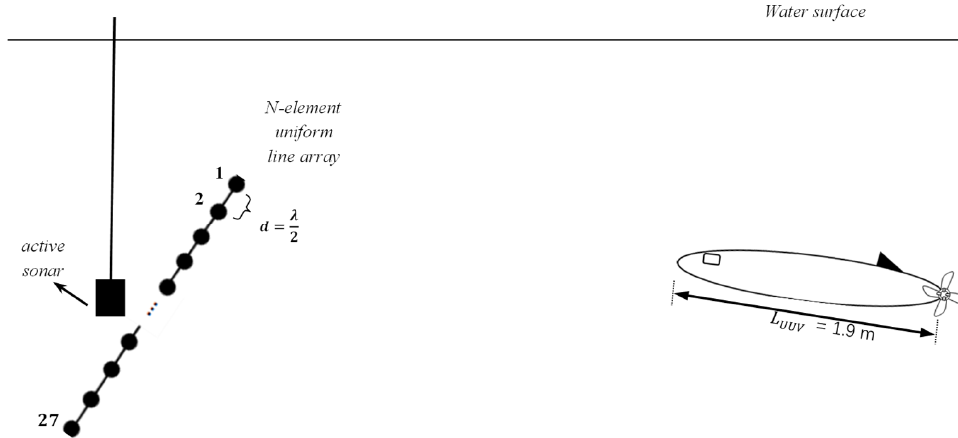
Figure 6. View of the underwater experiment scene layout.